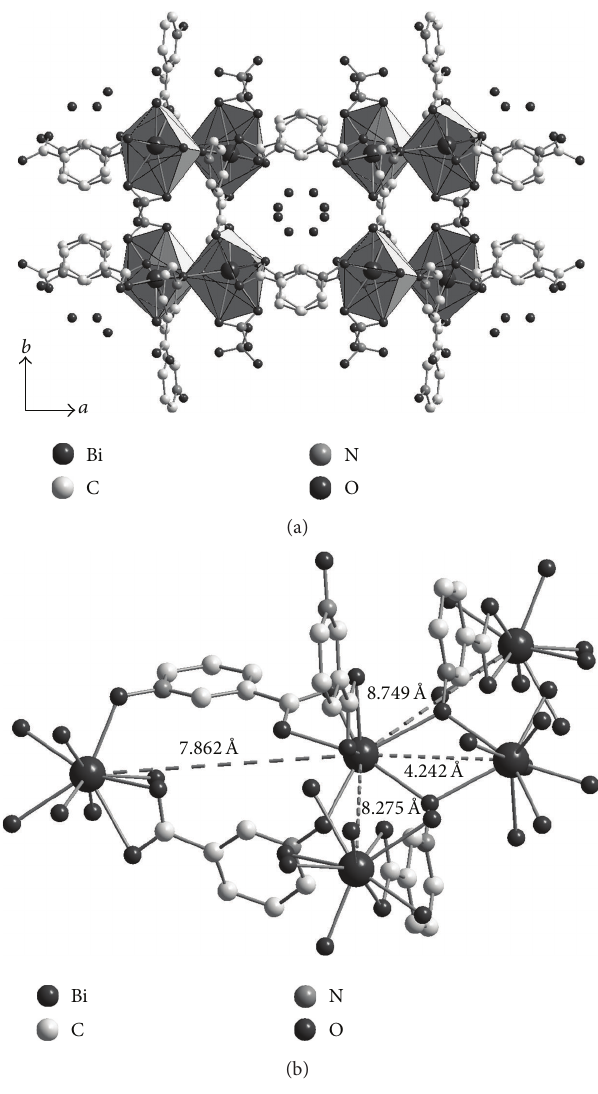
Figure 2: (a) View of the three-dimensional coordination polymer in the crystal structure of 1 along the crystallographic 𝑏 axis. The guest water molecules are located within the rectangular channels. (b)Bi − BidistancesandthecoordinationmodesoftheNNO − anions in 1